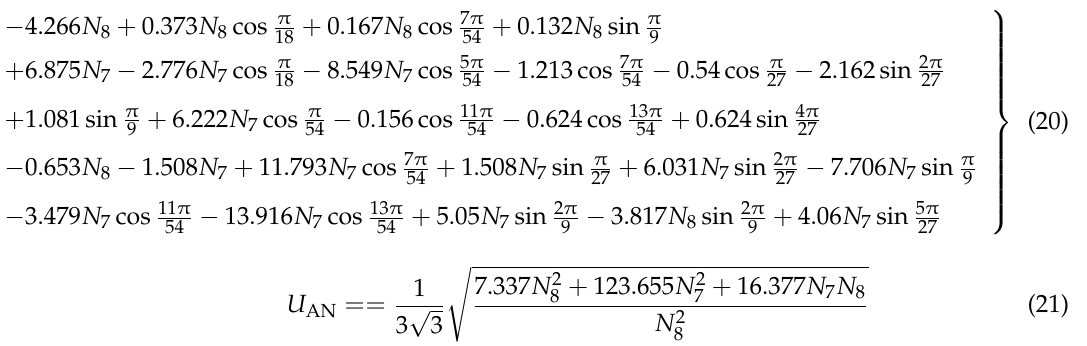
Figure 8. Voltage u AN in one supply cycle.